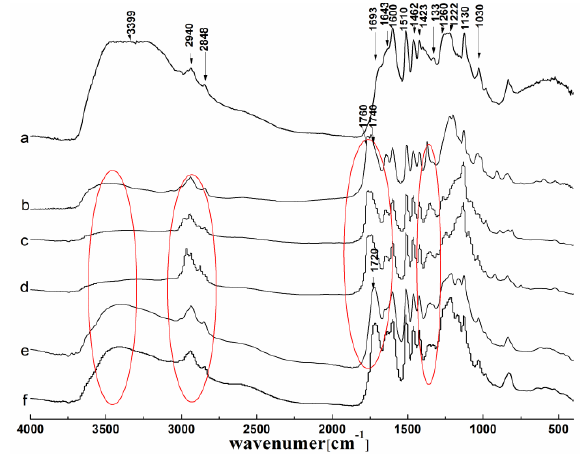
Figure 3. FTIR spectra of lignin and its esters: ( a ) original lignin; ( b ) acetylated lignin (1.5 h); ( c ) propionylated lignin (1.5 h); ( d ) butyrated lignin (2 h); ( e ) succinylated lignin (2 h); ( f ) maleylated lignin (2 h).